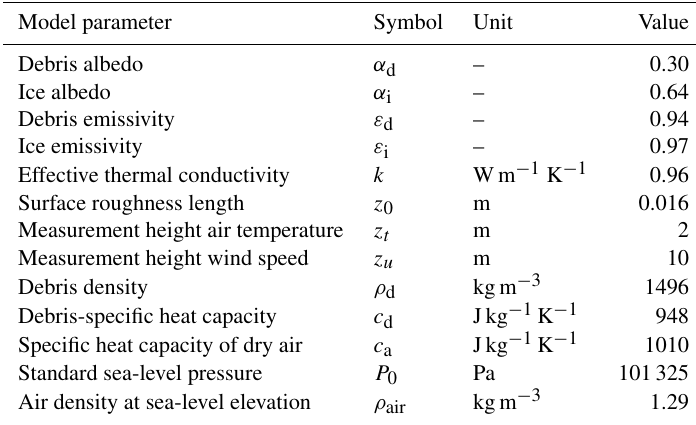
Table 1. Parameters used in the surface energy balance model.